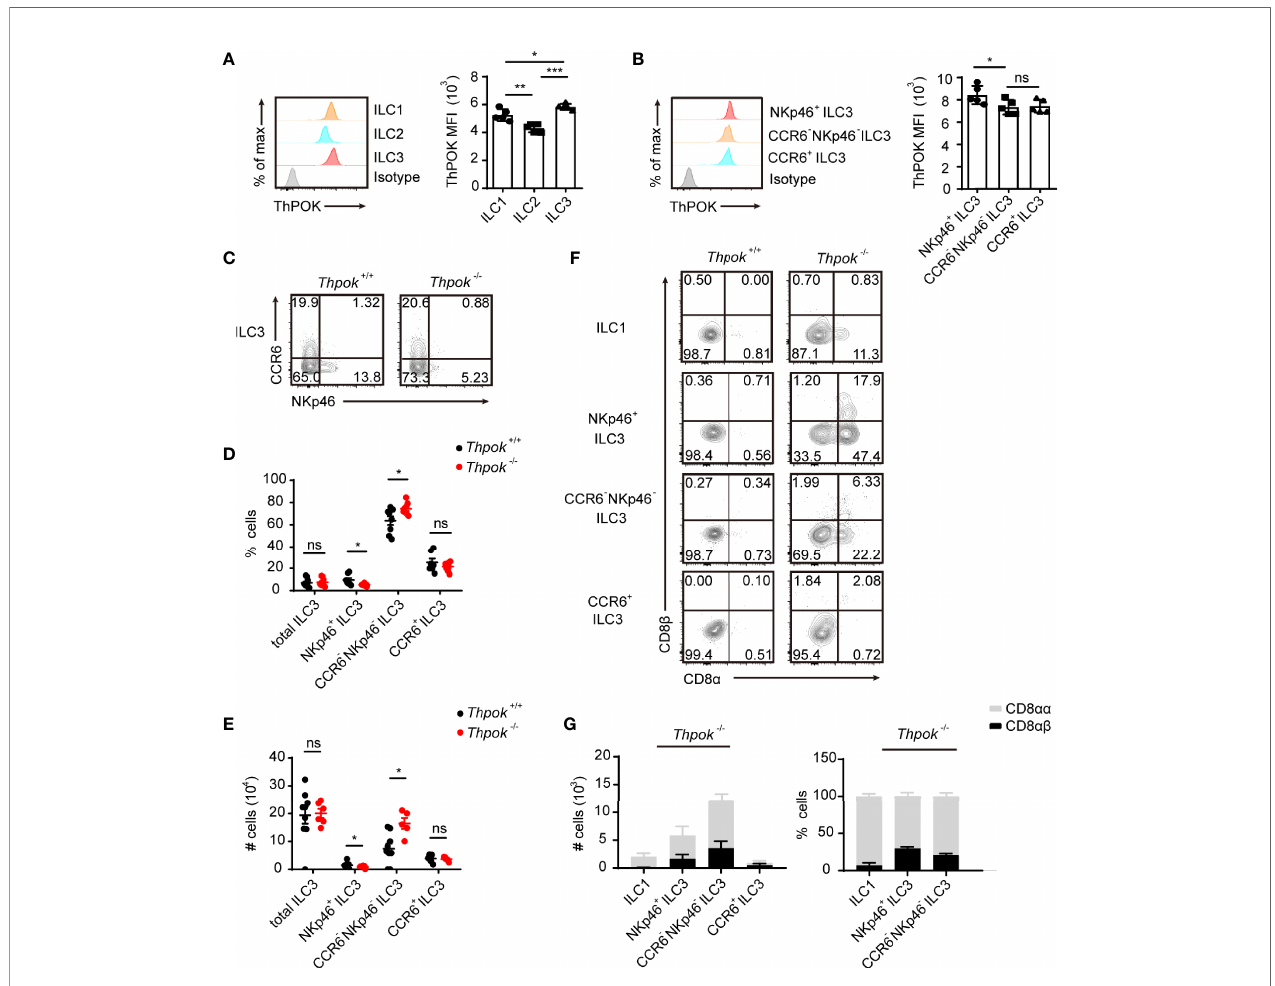
FIGURE 1 | Defects in ILC3 differentiation in ThPOK-de fi cient mice. (A) Protein expression of ThPOK in ILC1s, ILC2s and ILC3s isolated from the siLP of C57BL/6N WT mice as measured by fl ow cytometry. ILCs were de fi ned as Lineage- cells (lineage markers included TCR gd , CD3 ϵ , CD19, CD5, Gr-1 and Ter119). ILC1s were gated as Lin - NKp1.1 + NKp46 + Eomes - ROR g t - . ILC2s were gated as Lin - CD127 - KLRG1 + GATA3 + . ILC3s were gated as Lin - ROR g t + . Representative histograms show ThPOK expression. The isotype controls are the shaded curves, ILC1s are orange curves, ILC2s are blue curves and ILC3s are red curves (left). Mean fl uorescence intensity (MFI) of ThPOK in ILCs (right). ILCs were de fi ned as Lineage - cells (lineage markers included TCR gd , CD3 ϵ , CD19, CD5, Gr-1 and Ter119). (mean ± SEM; n = 5; * P < 0.05, ** P < 0.01, *** P < 0.001, Student ’ s t test). (B) Representative histograms showing expression of ThPOK by different siLP ILC3 subsets (left). CCR6 + ILC3s were gated as Lin - ROR g t + CCR6 + NKp46 - . NKp46 + ILC3s were gated as Lin - ROR g t + CCR6 - NKp46 + . CCR6 - NKp46 - ILC3s were gated as Lin - ROR g t + CCR6 - NKp46 - . The red, orange and blue curves represent NKp46 + , CCR6 - NKp46 - (DN) and CCR6 + ILC3s respectively. Mean fl uorescence intensity (MFI) of ThPOK in three subpopulations (right). (mean ± SEM; n = 6-9; *P < 0.05, Student ’ s t test). (C) Flow cytometry assay of the percentages of ILC3s from the small intestine. ILC3 subsets were stained as Lin - ROR g t + then CCR6 + NKp46 - , CCR6 - NKp46 - , or CCR6 - NKp46 + . Percentages (D) and total numbers (E) of different siLP ILC3 subsets. (mean ± SEM; n = 5-9; * P < 0.05, Student ’ s t test). (F) Flow cytometry analyzing CD8 a and CD8 b expression in ILC1s, NKp46 + , CCR6 - NKp46 - (DN) and CCR6 + ILC3s. (G) Quanti fi cation of CD8 aa and CD8 ab in indicated population from ThPOK-de fi cient mice. (mean ± SEM; n = 8; Student ’ s t test). Data are representative of at least three independent experiments. Statistical differences were tested using an unpaired Students ’ t-test (two-tailed). ns, no signi fi cant